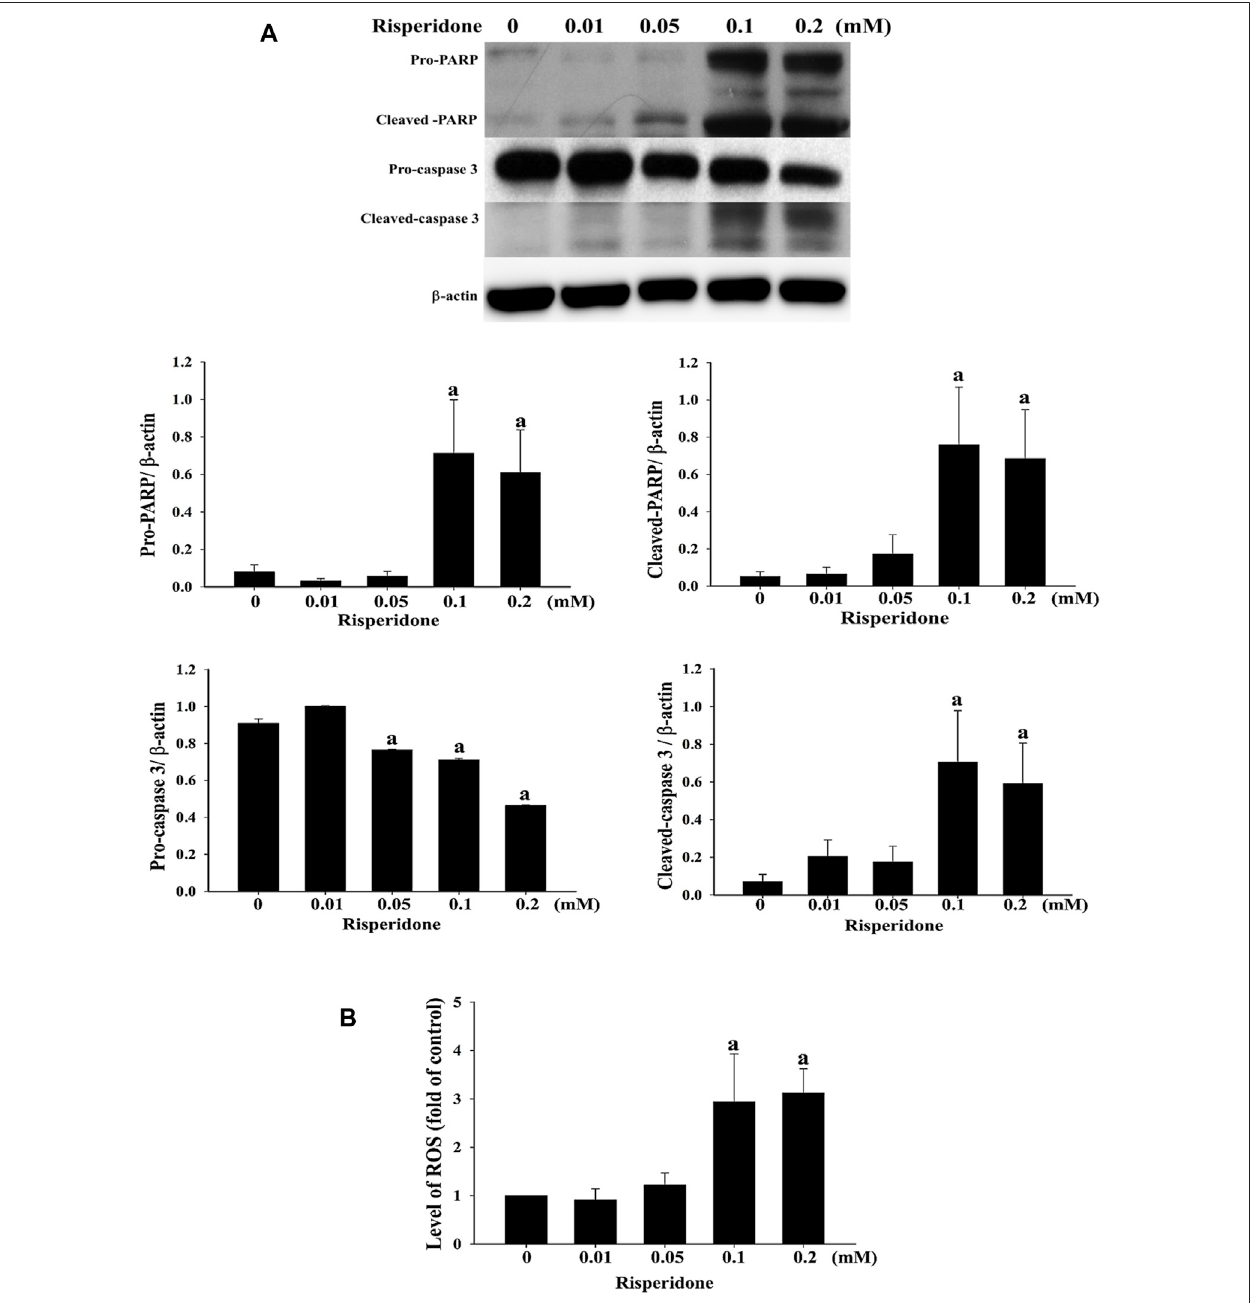
FIGURE3| RisperidoneincreasestheexpressionsofapoptoticproteinsandROS.KATO-IIIcellsweretreatedwithdifferentconcentrationsofrisperidonefor24 h. (A) Expressions of PARP, cleaved-PARP, pro-caspase 3 and cleaved-caspase 3 were detected with immunoblotting. (B) Level of ROS. Bars present the ratio on the basis of β -actin. Three-repeated tests were completed. The letter a indicates a signi fi cant difference ( p < 0.05) compared with control (0 mM).